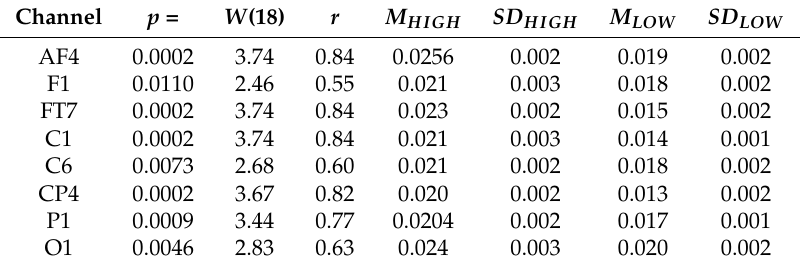
Figure A3. Eyes-Open (EO) setting. Channel-wise paired Wilcoxon rank sum test between total TEs of participants in HIGH and LOW stress-susceptible groups. There were significant differences between total TEs of 14 EEG channels. They were: AF4, F1, F4, FT7, CP3, CP4, CPZ, C1, C6, P1, PZ, PO7, PO8, and O1. In this figure, the asterisks mark these significant differences (* p < 0.05, ** p < 0.01, *** p < 0.001). Table A6. Eyes-Open (EO) setting. Channel-wise paired Wilcoxon rank sum test for eight channels (AF4, FT7, F1, C1, C6, CP4, P1, and O1) in which significantly higher total TEs were associated with HIGH stress-susceptible group. p , W , and r refer to p -value, test-statistics, and the effect size for Wilcoxon rank sum tests. M and SD are the mean and standard deviation of these channels’ total TE values. The subscripts to M and SD mark the two groups. All these significant differences were characterized by strong effect sizes, as indicated by the “ r ” column entry of this table.